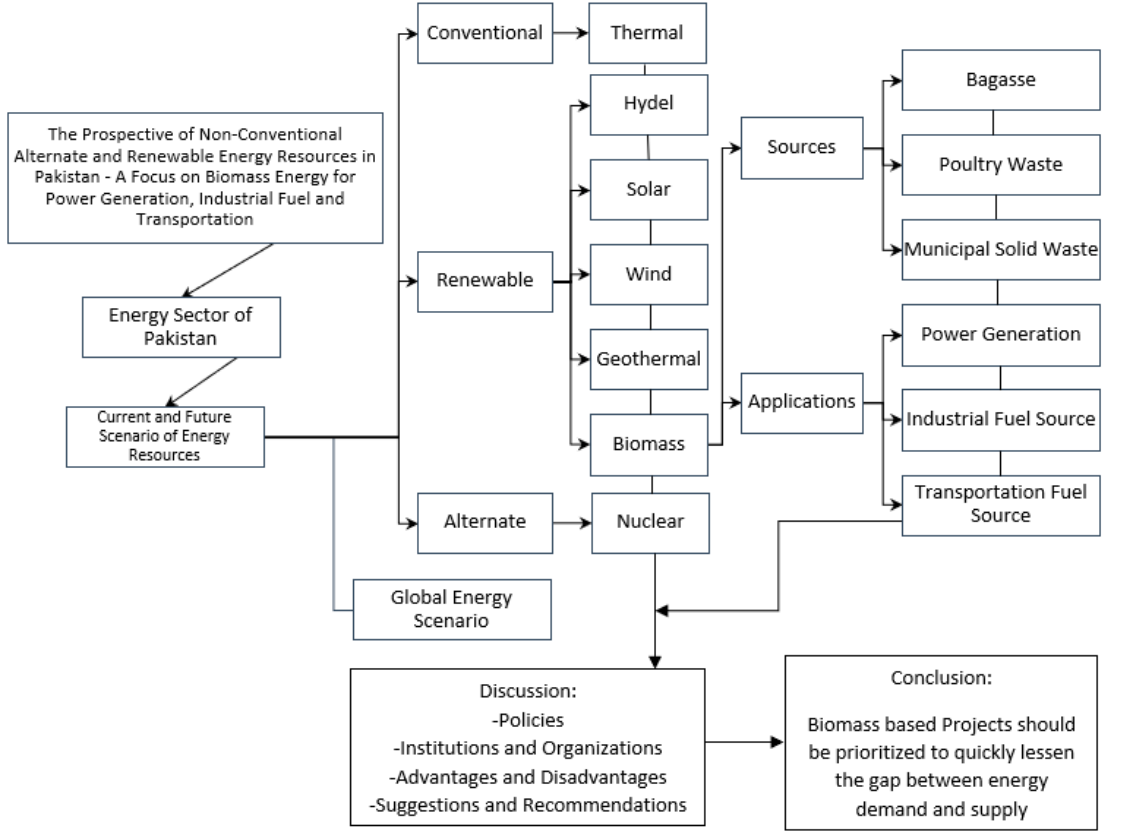
Figure 6. Graphical representation of the research methodology.